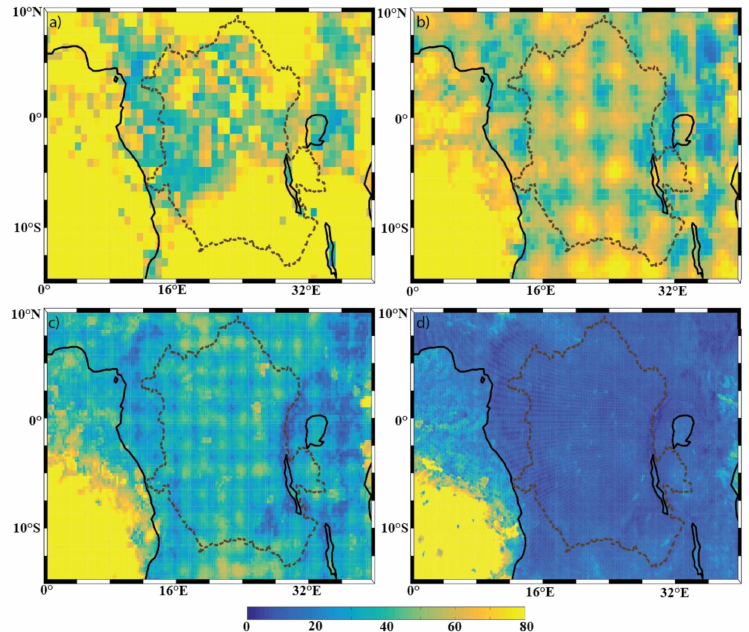
Figure 9. Spatial distribution of the P-E decorrelation length scale (km) of the ( a ) ERA-I; ( b ) eERA5; ( c ) ERA5; and ( d ) ECOA datasets from 2016–2017. The Congo Basin is outlined with a dotted line. Panels ( a ) through ( c ) have a colormap ranging from 20–150 km, and panel ( d ) has a colormap ranging from 0–30 km. The color bar at the bottom is applicable to all